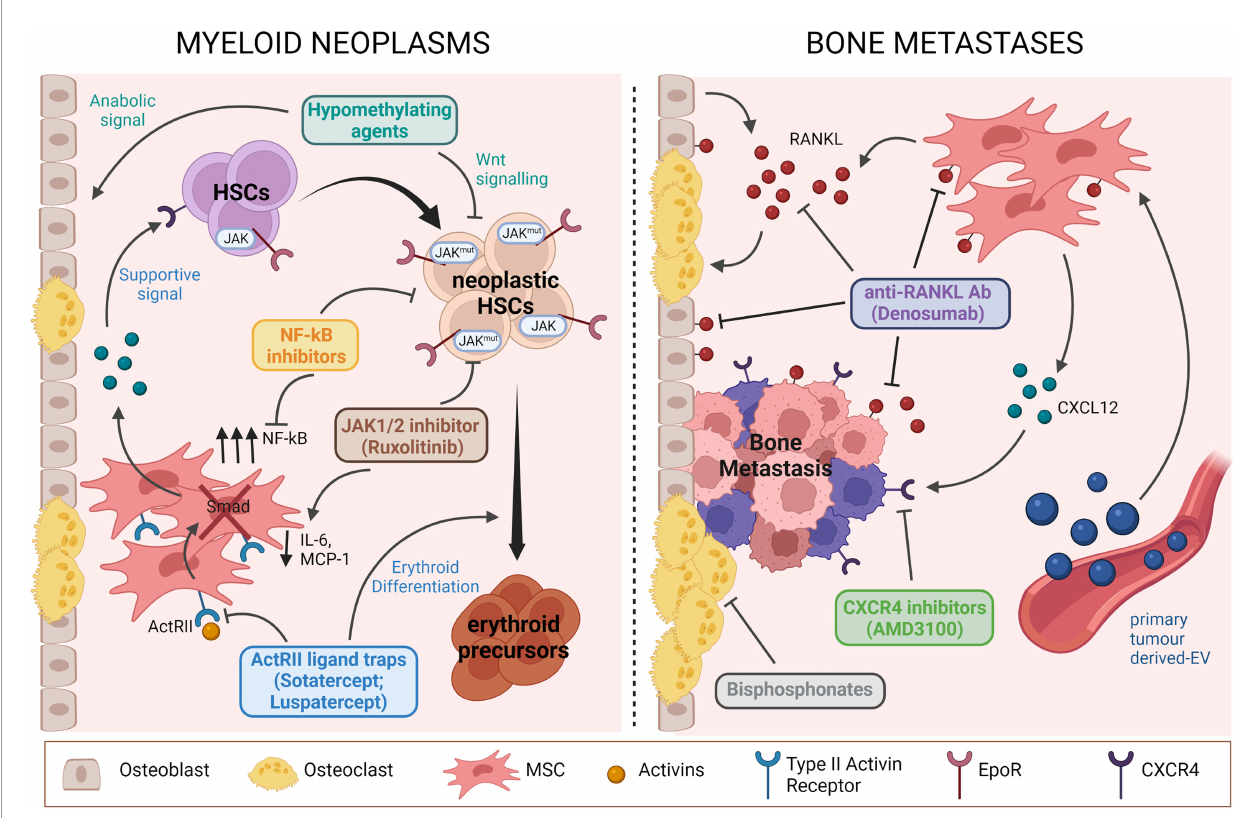
FIGURE 1 | Schematic representation of pathological mechanisms involving BM niche components targeted by current therapies for myeloid neoplasms (we show the example of MPN) and bone metastases. Drugs acting both on BM niche cells and TCs are highlighted. Figure was created with